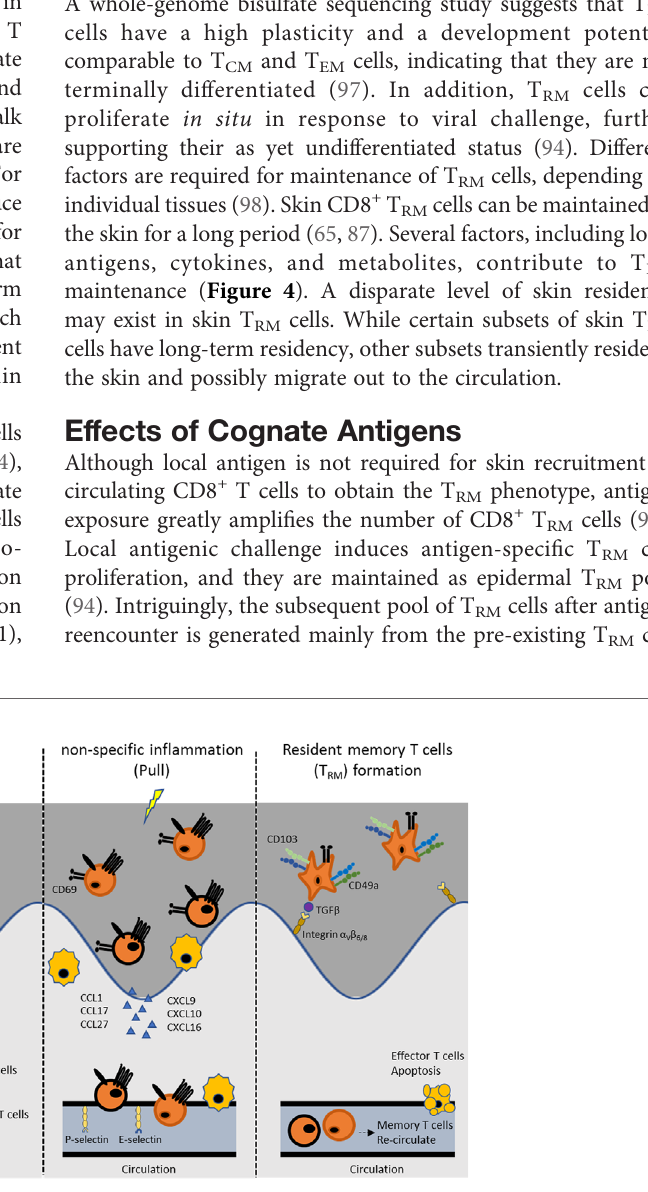
FIGURE 3 | Development of skin T RM